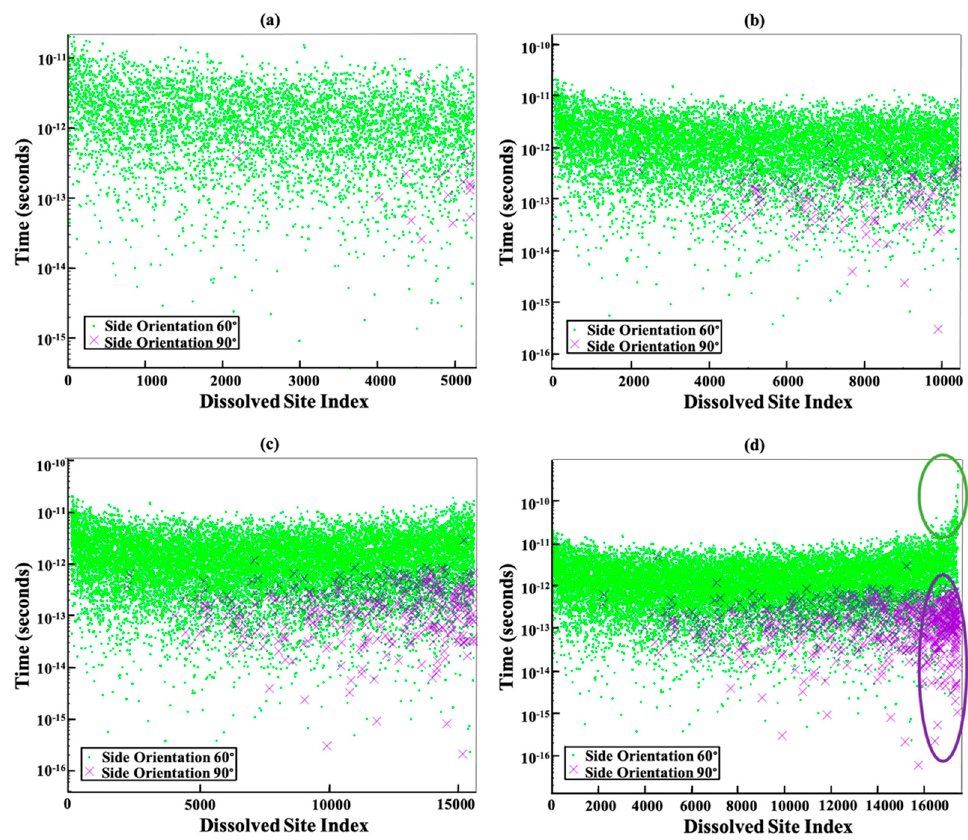
Figure 7. Each point or cross represents the dissolution time for each site along 5250 ( a ), 10,500 ( b ), 15,750 ( c ), and 17,461 ( d ) steps. Each step is representative of one site dissolution. Green point and purple cross show the time of each site dissolution, which take place from 010 or 0 10 (facet 60°), and 110 or 1 10 (facet 90°) facets, respectively.